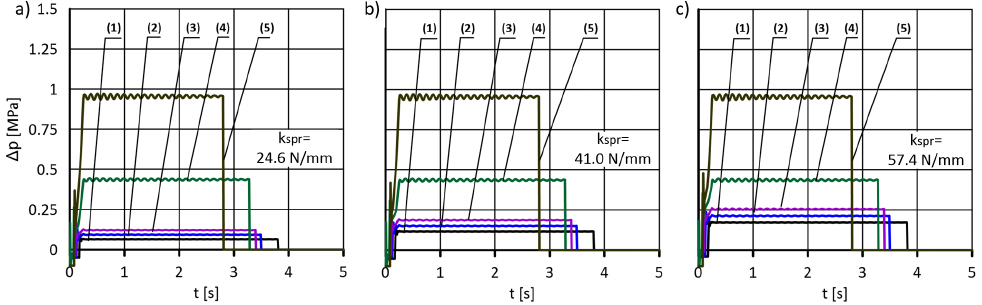
Figure 15. Pressure drop on check valve for different spring rates: ( a ) reduced, ( b ) nominal, ( c ) increased; flow direction